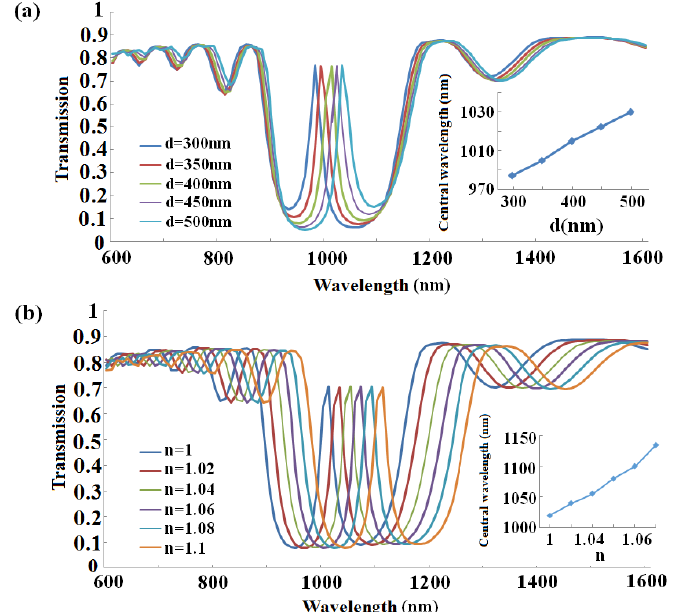
Figure 8. Characterization of the MIM-based Bragg grating with a defect ( a ) transmission spectra as a function of wavelength with different defect width d ; ( b ) transmission spectra as a function of wavelength with different effective index n .